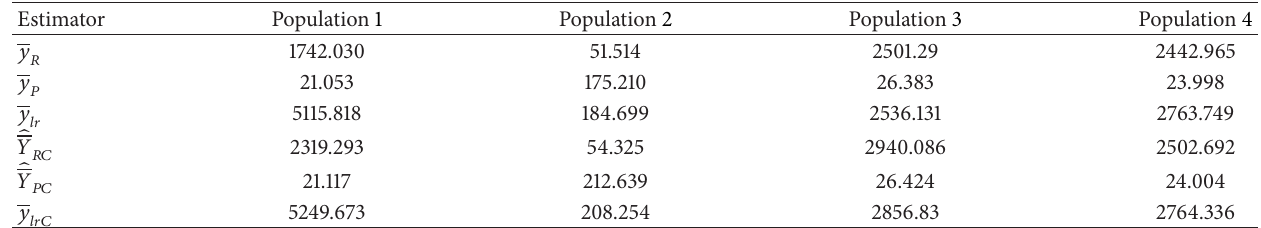
Table 2: PRE of different estimators with respect to 𝑦